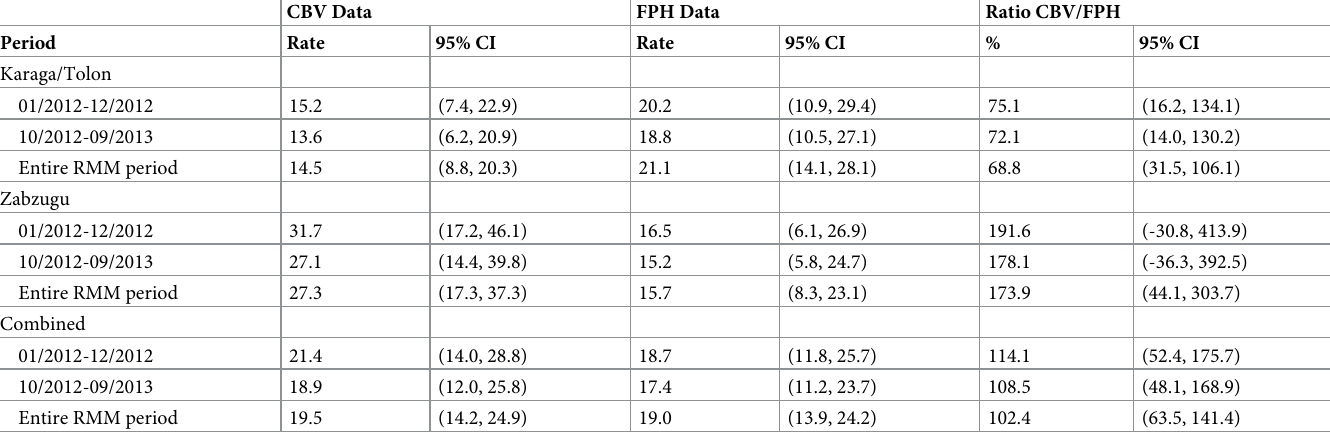
Table 6. Neonatal mortality rates estimated from CBV records and FPH data and corresponding 95% confidence